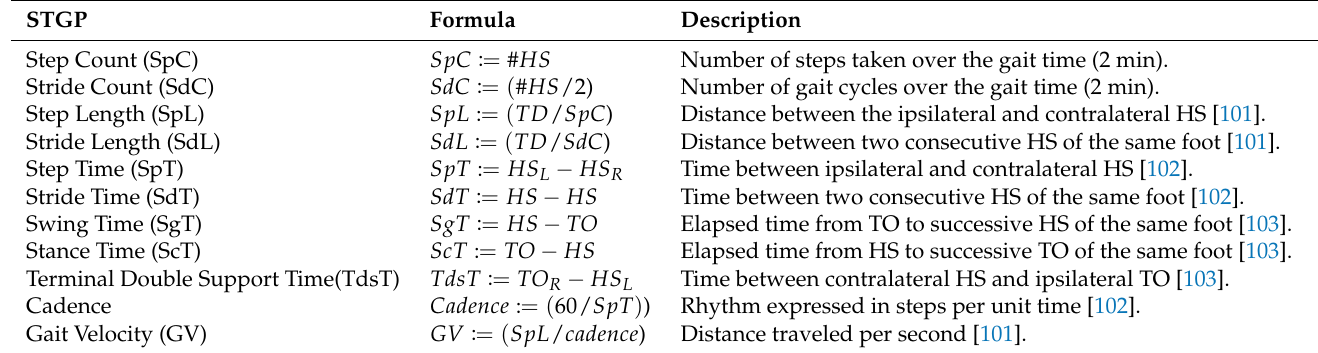
Table 4. Operational definitions of spatial-temporal gait